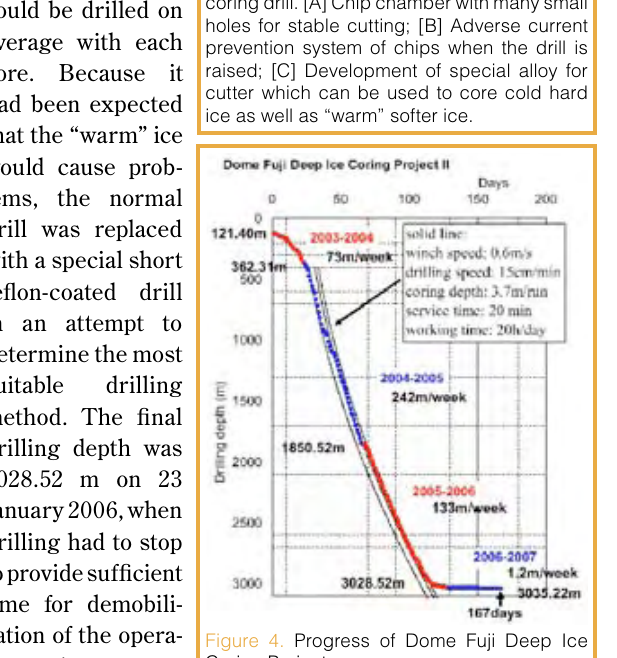
Figure 4. Progress of Dome Fuji Deep Ice Coring